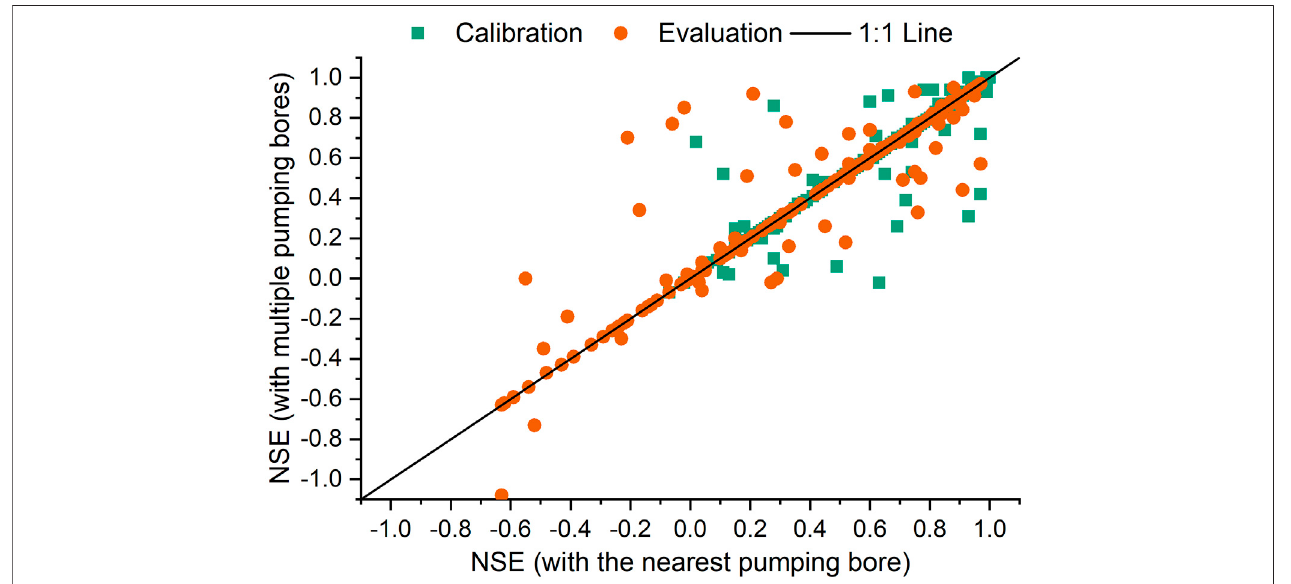
FIGURE 6 | Comparison NSE results between the climate and pumping analysis with the nearest pumping bore and multiple pumping bores.